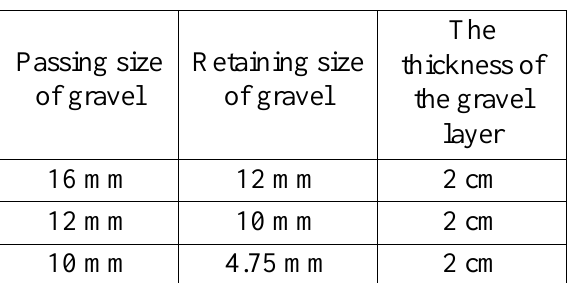
Table 2. Details of the sand layer Passing size